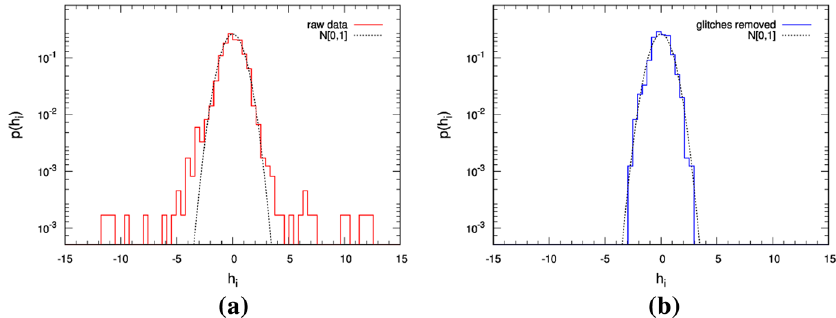
Fig.76 Histogramsofthewhitenedtime-domaindatashowninFig.75.Panel a iswithoutglitchsubtraction, while panel b is with glitch subtraction. Images provided by Tyson